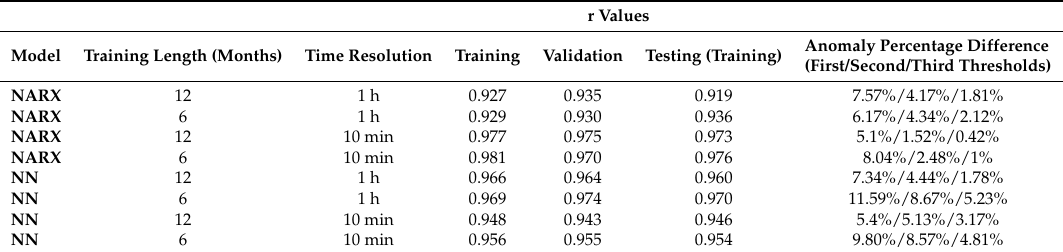
Table 3. Comparison of models’ anomaly detection performance for case study